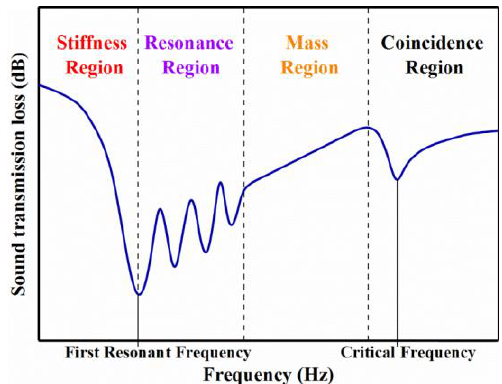
Figure 2. A typical sound transmission loss (STL) curve showing the stiffness, resonance, mass, and coincidence coincidence regions.